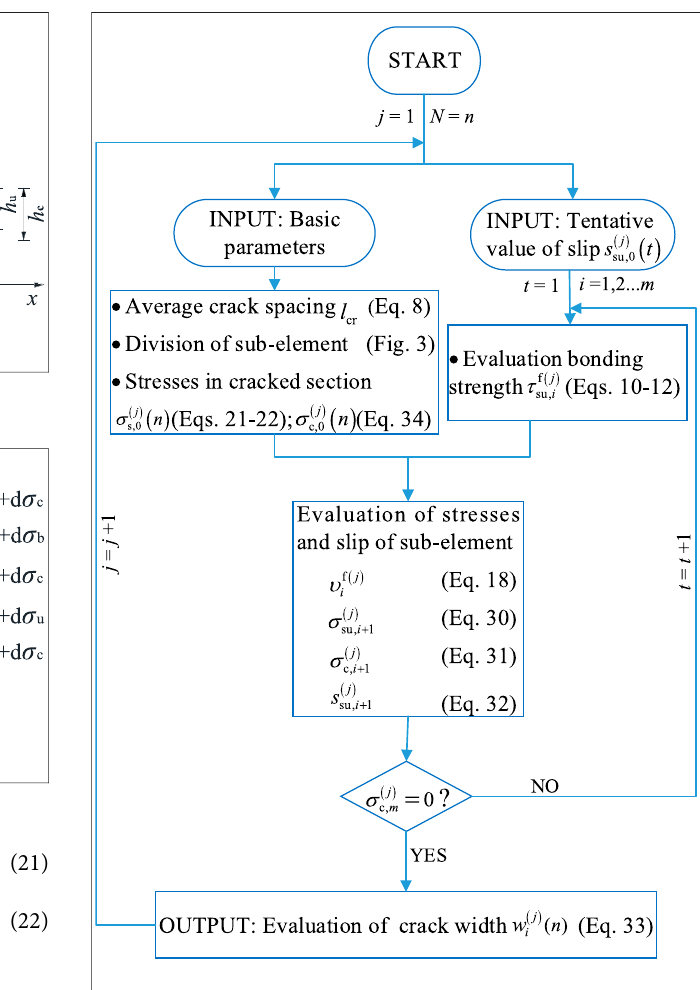
FIGURE 5 | Flowchart of the numerical solution of crack